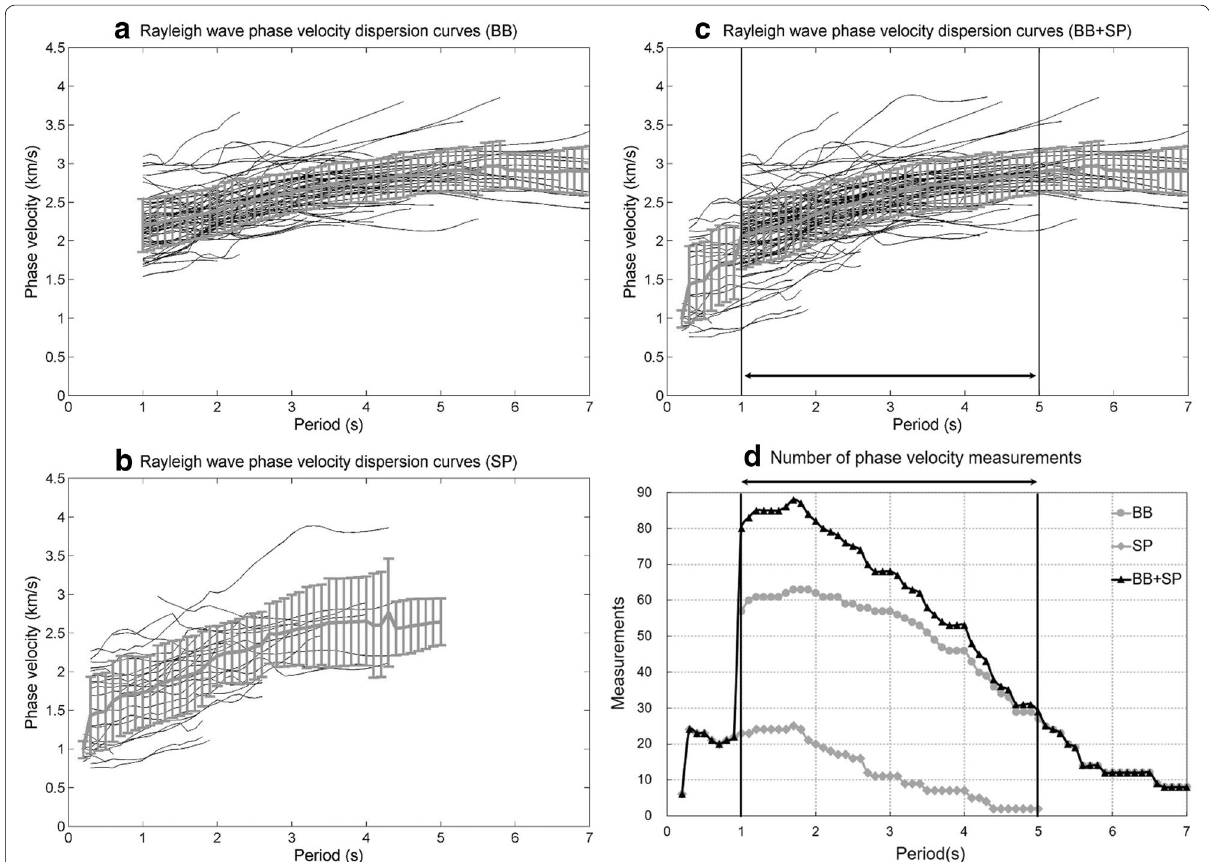
Fig. 7 Measured Rayleigh‑wave phase‑velocity dispersion curves: a BB station pairs; b SP station pairs; c integrated BB and SP station pairs. In a – c , the black lines indicate individual dispersion curves and the gray lines are the averages with standard deviations. d Number of phase‑velocity measurements in a – c for each period. Phase‑velocity maps were constructed from the 1–5‑s period